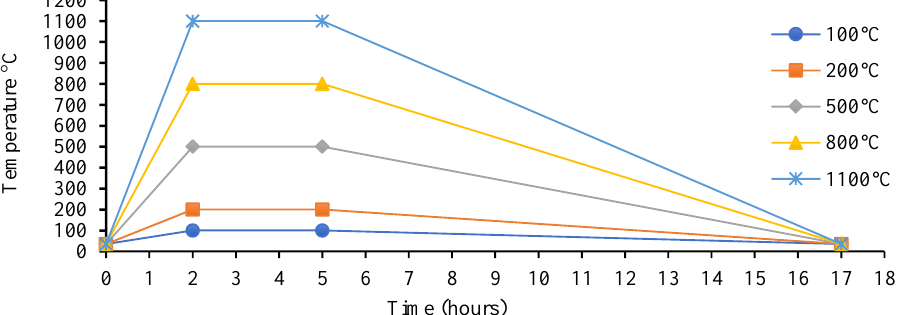
Figure 20. Thermal loading ( ◦ C) for the geopolymer material paste using various SS-to-SH (%) and Figure 20 . Thermal loading (°C) for the geopolymer material paste using various SS-to-SH (%) and FA-to-GGBS ratios with sand preheated at 110 ◦ C. FA ‒ to ‒ GGBS ratios with sand preheated at 110 °C.